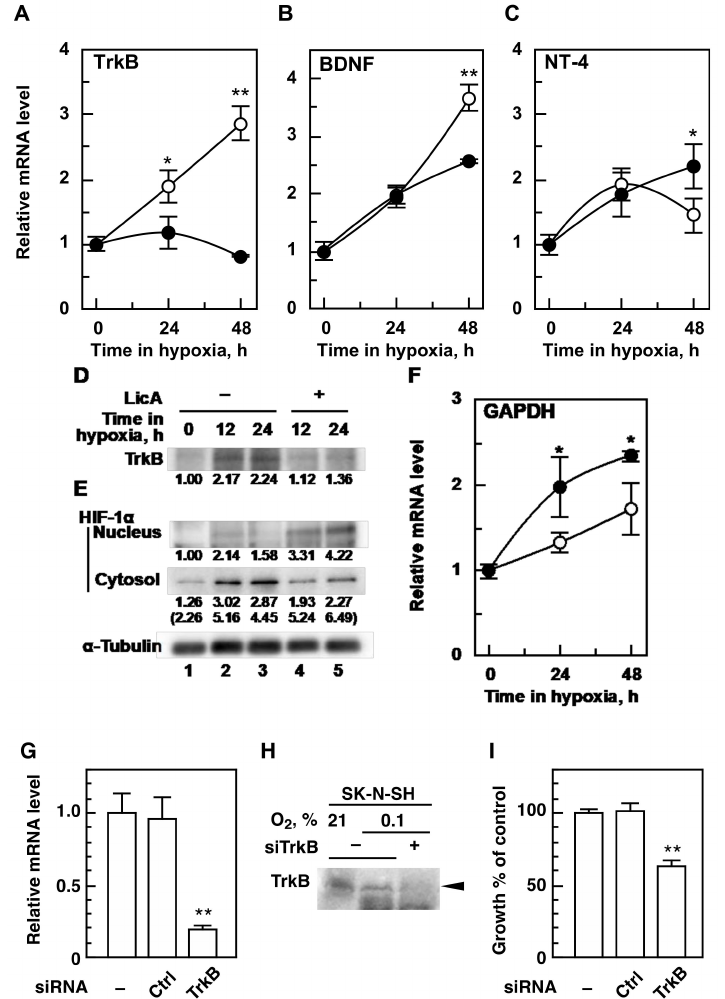
Figure 2. Inhibition of TrkB and brain-derived neurotrophic factor (BDNF) expression in SK-N-SH. ( A – C , F ) Cells (2 × 10 4 cells / well) were cultured in hypoxia for the indicated periods with 20 µ M LicA (closed circles) and without (open circles), and total RNA was isolated. mRNA levels were determined by quantitative reverse-transcription polymerase chain reaction (qRT-PCR). ( D ) Inhibition of TrkB at the protein level by 20 µ M LicA was determined by immunoblot. ( E ) A specific band of HIF-1 α in the cytosol and nuclear fractions of cells treated with or without 20 µ M LicA in hypoxia was detected by immunoblot. ( G ) Cells (2 × 10 5 cells / well of a 24-well plate) were cultured for 24 h in normoxia and transfected with siRNA. Cells were further cultured for 24 h in hypoxia and total RNA was isolated. mRNA levels were determined as described above. ( H ) Cells (1 × 10 6 cells / 10 cm dish) were cultured and transfected with siRNA as described in ( G ). Inhibition of TrkB at the protein level by TrkB knockdown was determined by immunoblot. ( I ) Cells (3 × 10 3 cells / well of a 96-well plate) were cultured and transfected with siRNA as described in ( G ). After 48 h culture in hypoxia, cell growth was determined as described in Figure 1B. * p < 0.05, ** p <